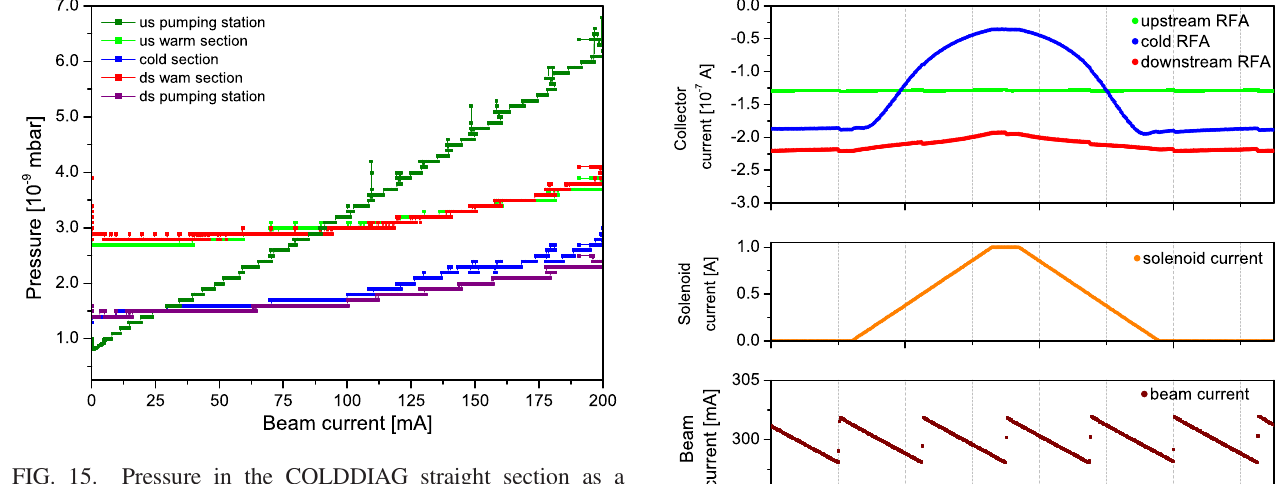
FIG. 15. Pressure in the COLDDIAG straight section as a function of beam current, with a fill pattern of 460 consecutive bunches.